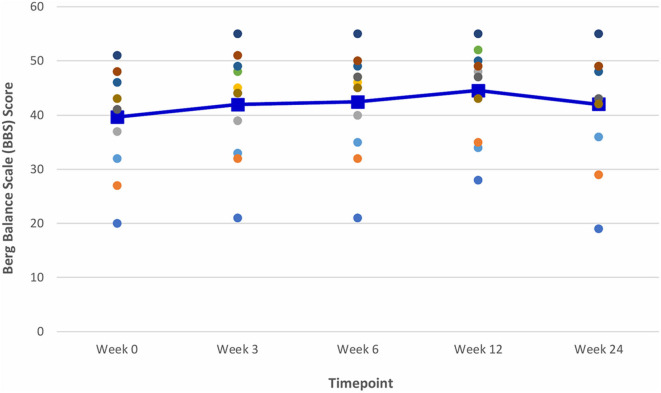
Time series plot showing the secondary outcome measure of Balance Berg Scale (BBS) score. Each circle • represents a study subject. A trend line (–) has been superimposed to illustrate the change in the mean ± SD BBS score from baseline pre-intervention (i.e., Week 0) to final follow- up post-intervention (i.e., Week 24).